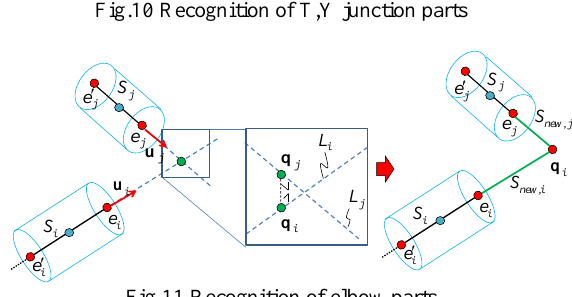
Fig.10 Recognition of T,Y junction